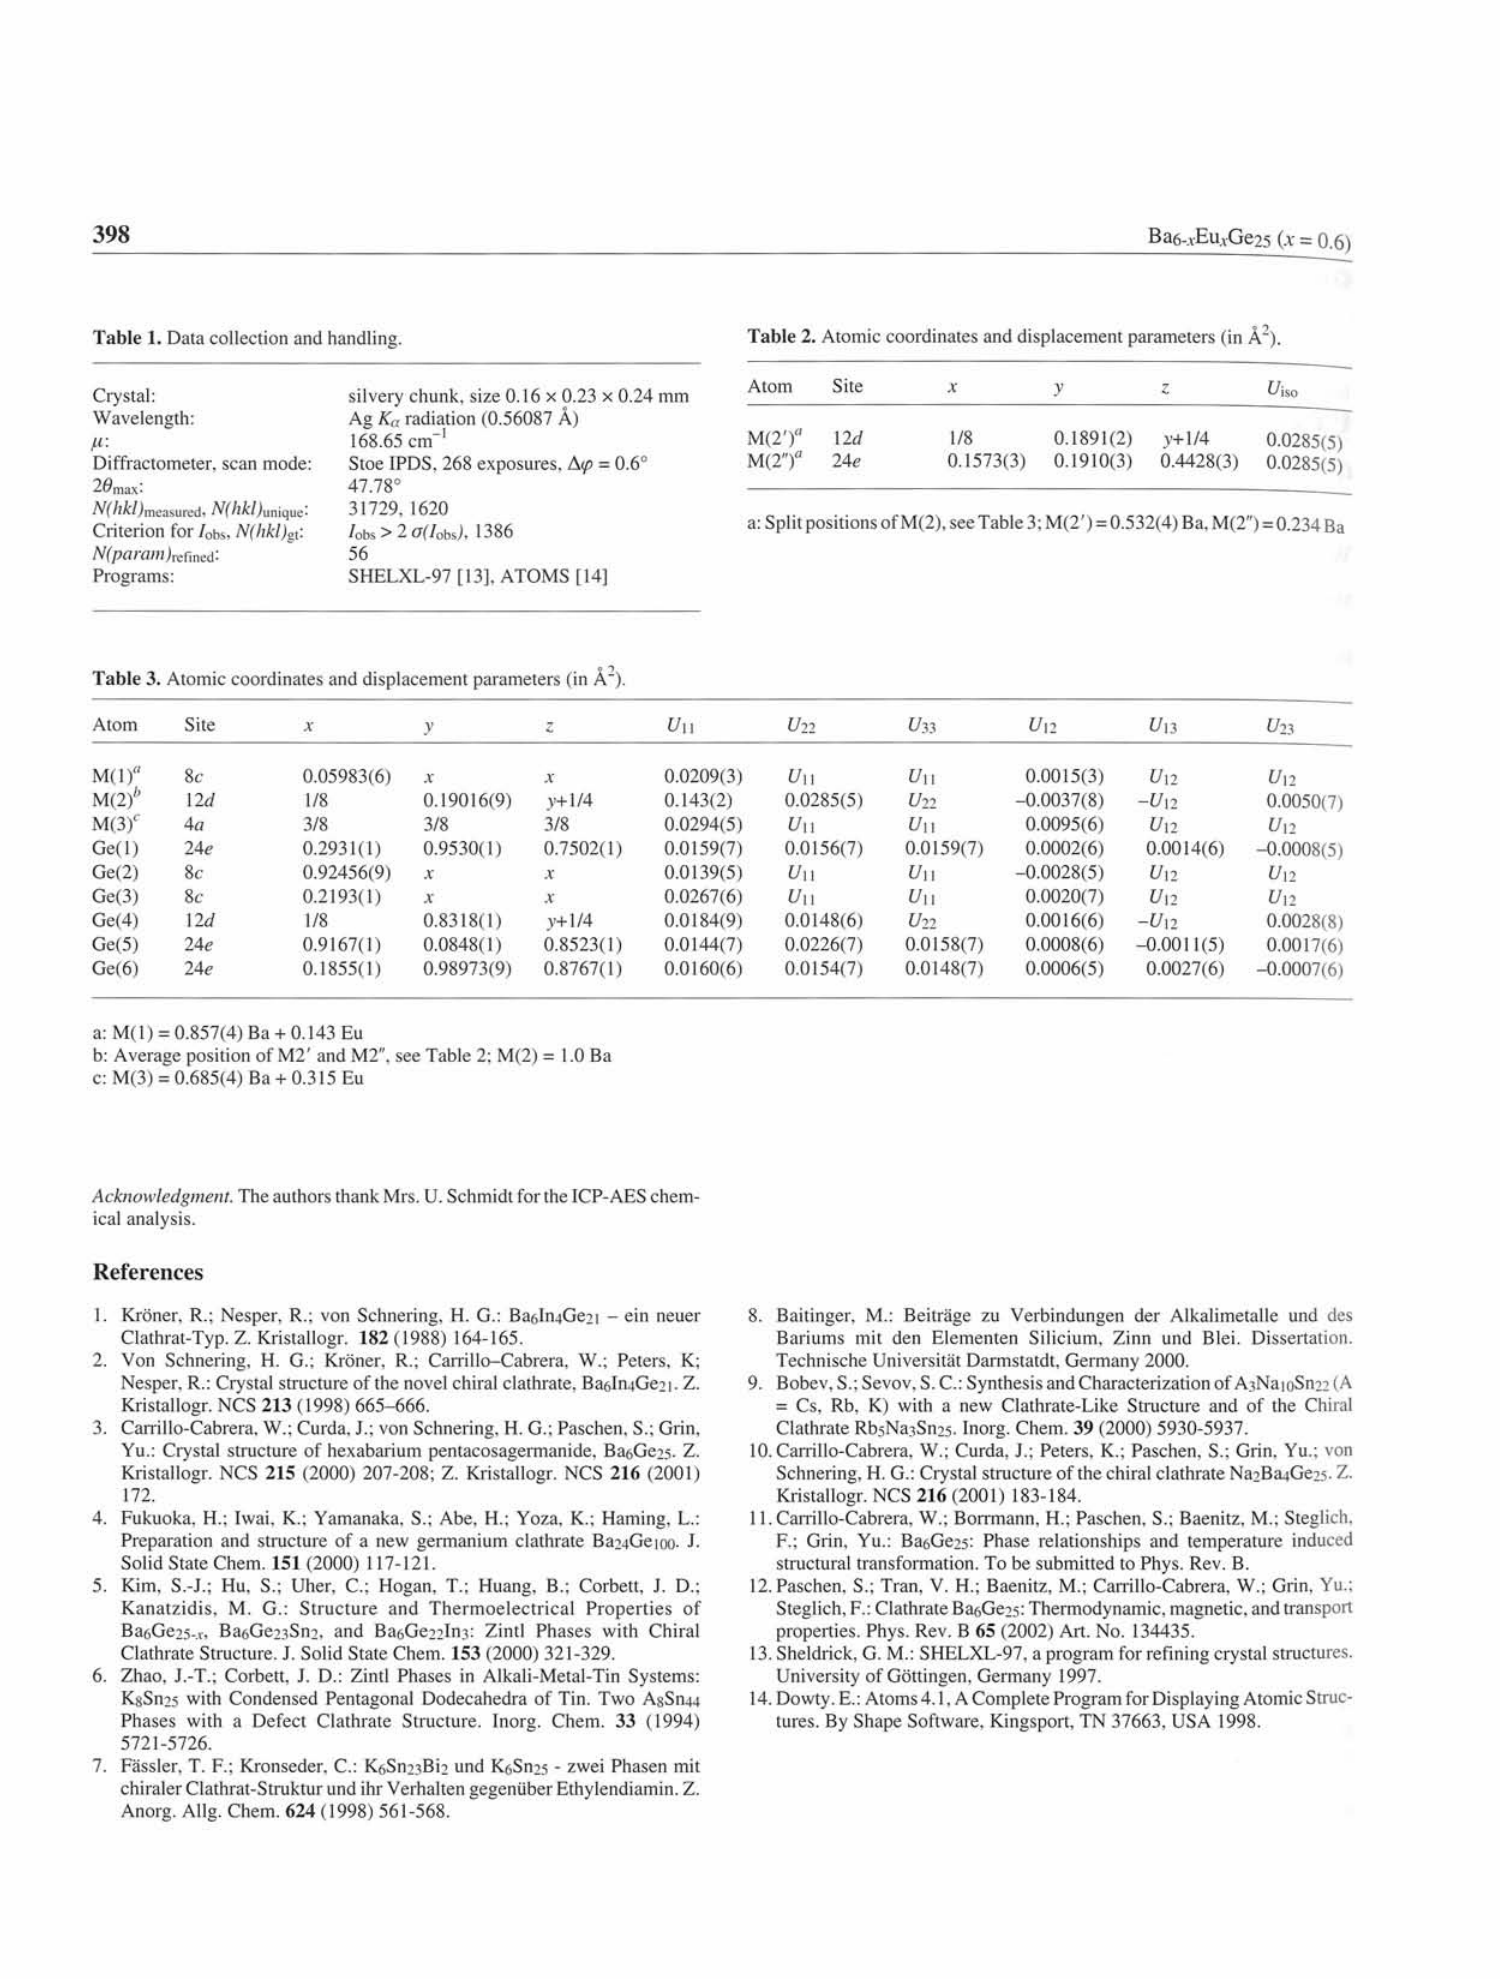
Table 2. Atomic coordinates and displacement parameters (in Â 2